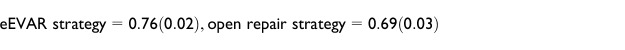
Illustration of the estimation of treatment effectiveness using a pattern-mixture model that allows for outcome data to be MNAR.
μ represents the mean QoL for patients who returned their QoL questionnaires, δ represents the difference in the mean QoL between patients who did and did not return their QoL questionnaires and π represents the proportion of patients who did not return their QoL questionnaires. E and O indicate the eEVAR and open repair treatment groups respectively.Simple arithmetic example that uses hypothetical elicited values to re-calculate the effectiveness of eEVAR versus open repair on QoL score. The example uses a pattern-mixture model to allow for data that are MNAR.Information from QoL data that are observed in the RCT:sample mean (SE) QoL score for patients who completed QoL questionnaire
eEVAR strategy=0.76(0.02),open repair strategy=0.69(0.03)
proportion of patients who did not return their QoL questionnaire
eEVAR strategy=0.18,open repair strategy=0.24
Information elicited from an expert:mean (SD) of difference in mean QoL between patients who did and did not return their QoL questionnaire
eEVAR strategy=−0.01(0.04),open repair strategy=−0.05(0.1)
Then a point estimate of the treatment difference can be calculated as
(μE+πEδE)−(μO+πOδO)=(0.76−0.18×0.01)−(0.69−0.24×0.05)=0.08.
Assuming independence between variables, the variance (V) of the treatment difference is
V(μE)+πE2V(δE)+V(μO)+πO2V(δO)=0.022+0.1820.042+0.032+0.2420.12=0.002,
and a 95% confidence interval (CI) for the treatment difference can be estimated as
(0.08−1.96×0.044,0.08+1.96×0.044)=(−0.01,0.17)
Hence using a pattern-mixture model with expert information reports an estimate of the effectiveness of eEVAR versus open repair of treatment difference (95% CI) of 0.08 (−0.01, 0.17), compared to 0.07 (0.00, 0.14) for calculations based on the observed QoL alone. Note the wider confidence interval from using the pattern-mixture model, as this approach takes account of the uncertainty from the missing data that may be MNAR.